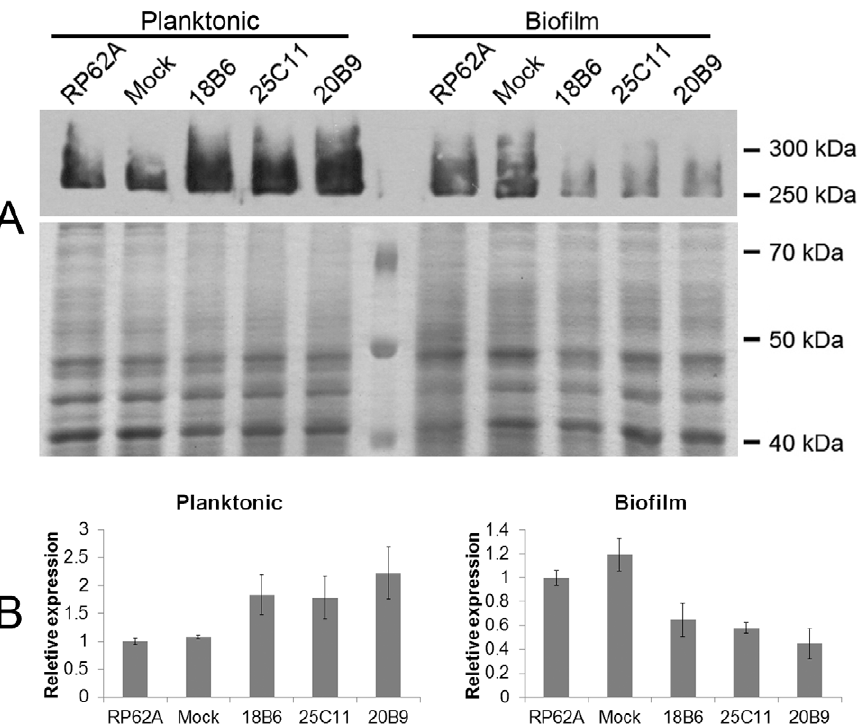
Figure 5. Aap expression in S.epidermidis . (A) Protein expression level. Aap expression in S. epidermidis RP62A co-cultured with each MAb (10 m g/mL) was detected using Western blot with MAb 25C11 (1 ng/mL). After separation of the proteins using 7% SDS-PAGE, the gel pieces carrying high molecular-weight proteins ( . 130 kDa) were excised for Western blot assay, and the remaining gel was stained using Coomassie brilliant blue as the endogenous control. (B) Relative transcriptional level. The transcriptional level of aap was detected by Q-RT-PCR using RNA sample extracted from S. epidermidis RP62A co-cultured with each MAb (10 m g/mL). The housekeeping gene gyrB was used as an endogenous control, and all samples were analyzed in triplicate and normalized against gyrB transcription (means 6 SD). ‘‘RP62A’’: untreated, ‘‘Mock’’: normal mouse IgG-treated.